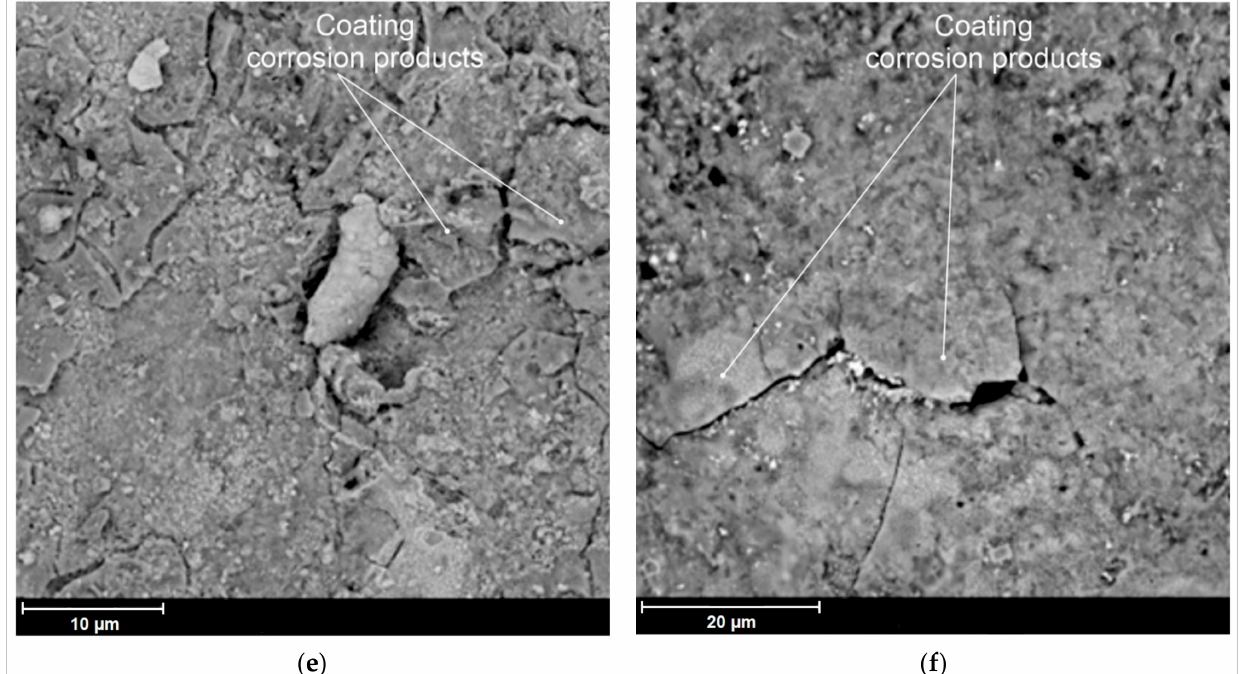
Figure 8. Surface morphology after high-temperature corrosion resistance tests at 800 ◦ C for 1000 h: